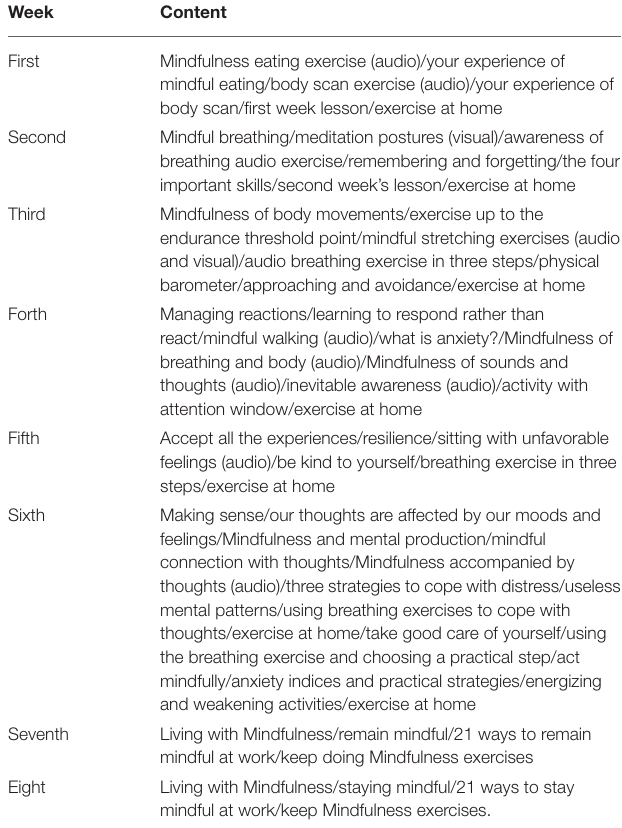
TABLE 3 | Eight weeks of exercise using the Mindfulness training